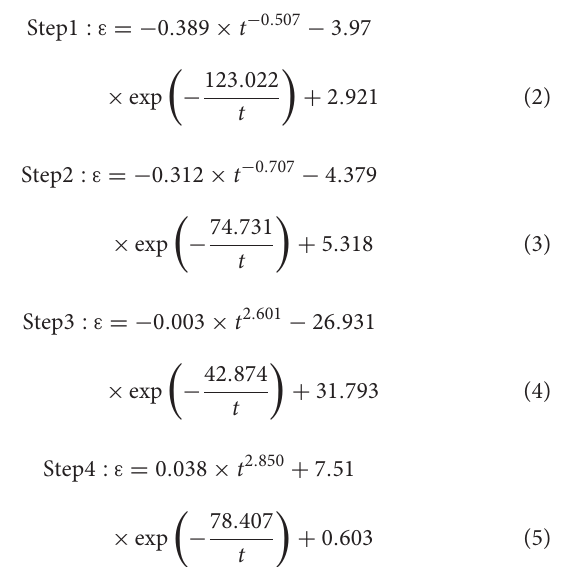
approach, the creep deformation models for every step of testing are as